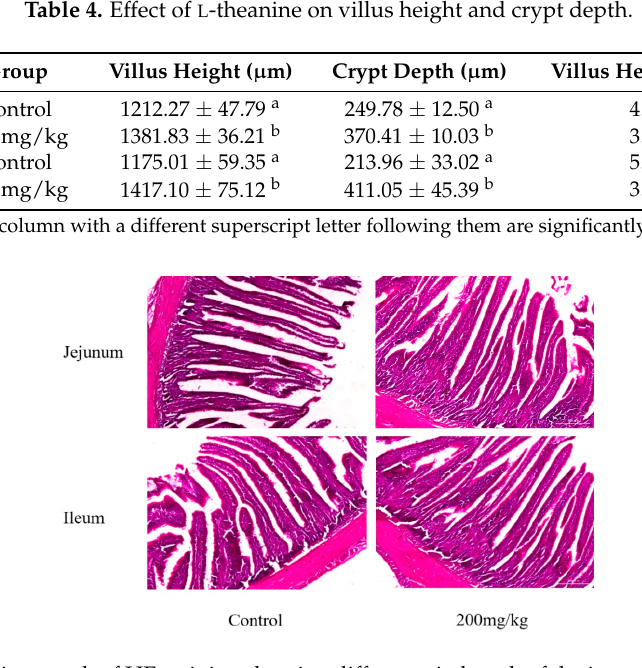
Table 3. Meat quality traits of broilers as affected by dietary L -theanine supplementation within 42 days of age.